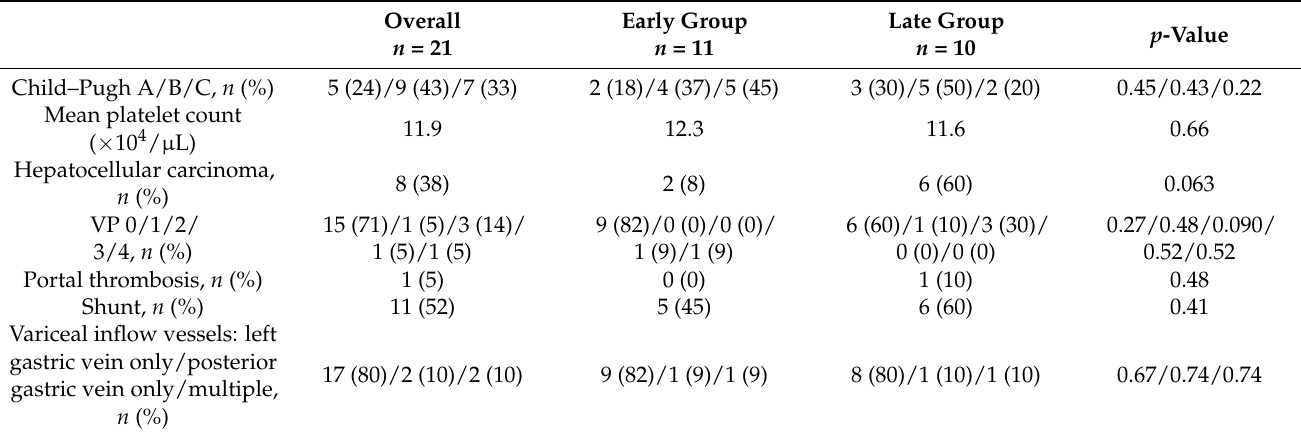
Table 5. Factors associated with early bleeding in the follow-up group: liver cancer, hepatic functional reserve and hemodynamics.